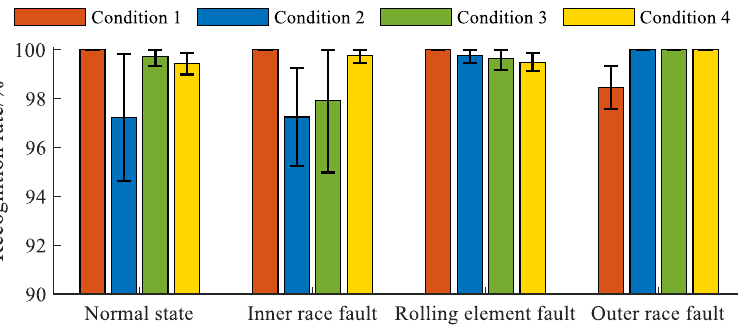
Figure 6. Average diagnosis result of each in-wheel motor fault with different training options.